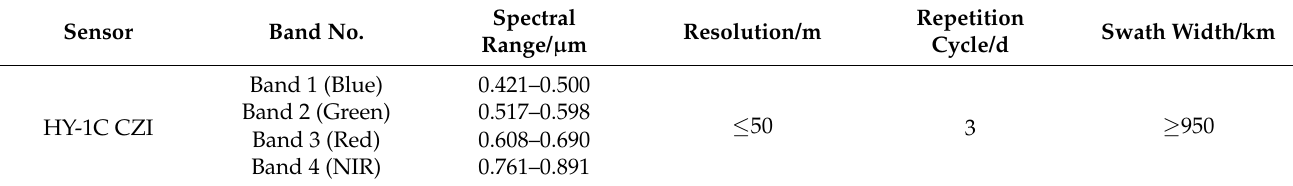
Table 3. Introduction of HY-1C CZI sensor